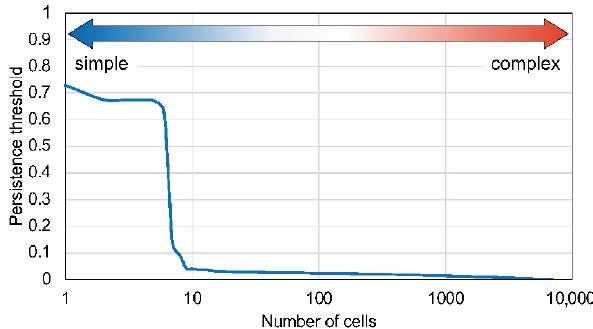
Fig. 7 A line chart of the minimum persistence with respect to the number of cells in the example of plastic cases in Fig. 6(b). The MSG simplification proceeds from right to left, monotonically increasing the minimum persistence while the number of cells decreases. The minimum persistence τ is set to the value in the middle of a large gap, which will be 0.4 in this figure.